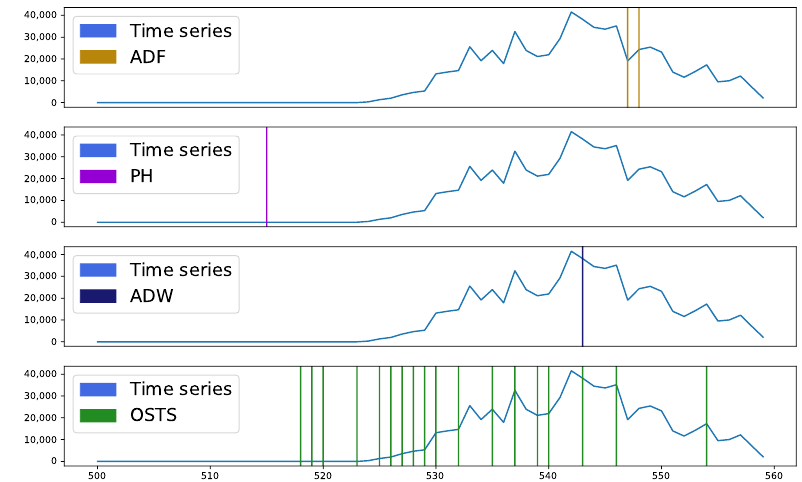
Figure 4. Segmented samples of dataset A (chunk from 500 to 560 samples). ADF removed 2 samples, PH and ADW removed a single sample, and OSTS removed 17. The stationarity-based segmenters considered the range from 515 to 543 as stable and without the need for segmentation, while the OSTS segmenter performed quite a lot of segmentation at these points.